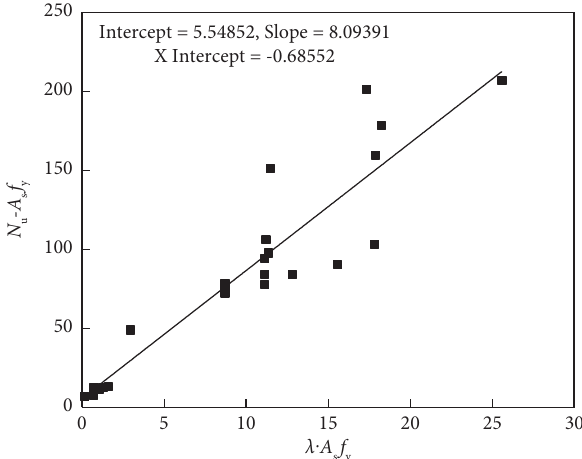
Figure 21: Axial pull formula ftting